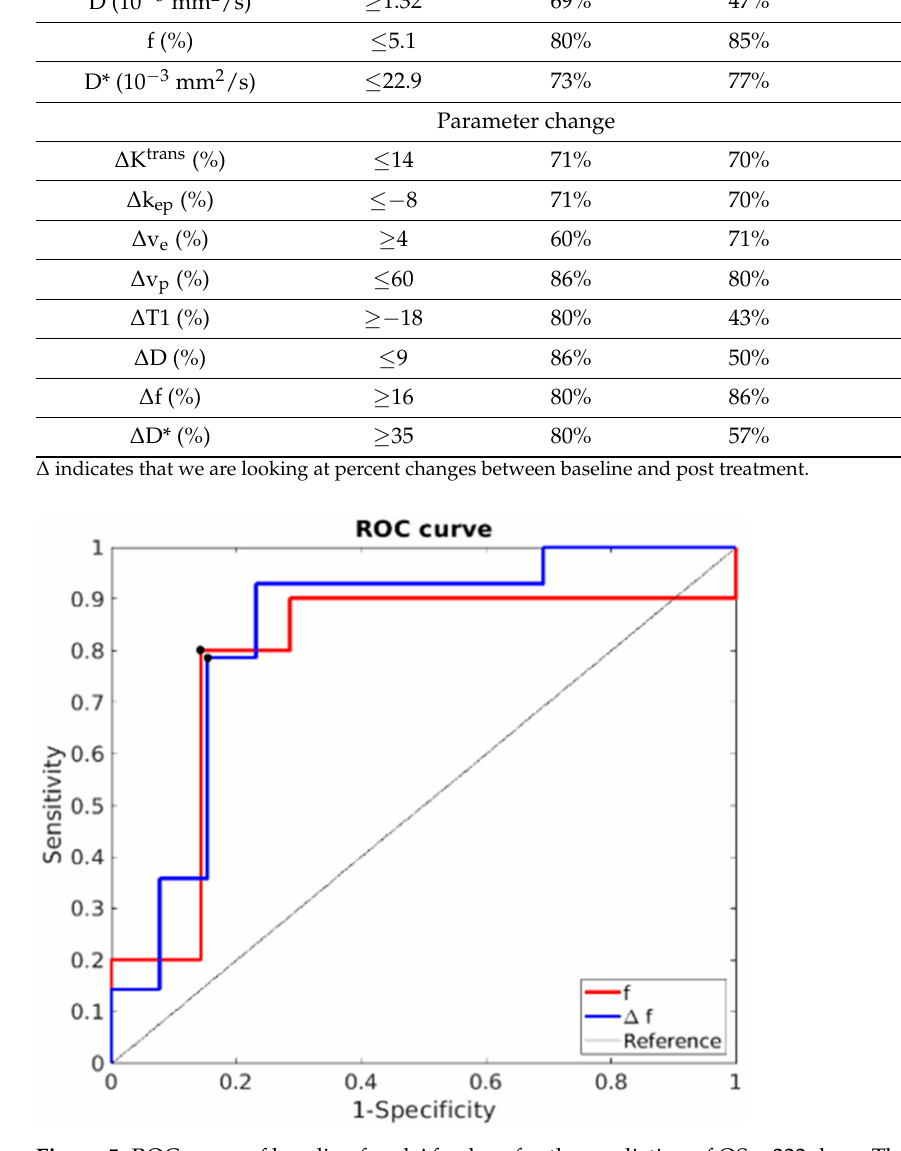
Figure 5. ROC curve of baseline f and ∆ f values for the prediction of OS > 222 days. The black dots indicate the cut-off values on which the sensitivity and specificity are determined. The AUC of f and ∆ f are 0.846 and 0.786,